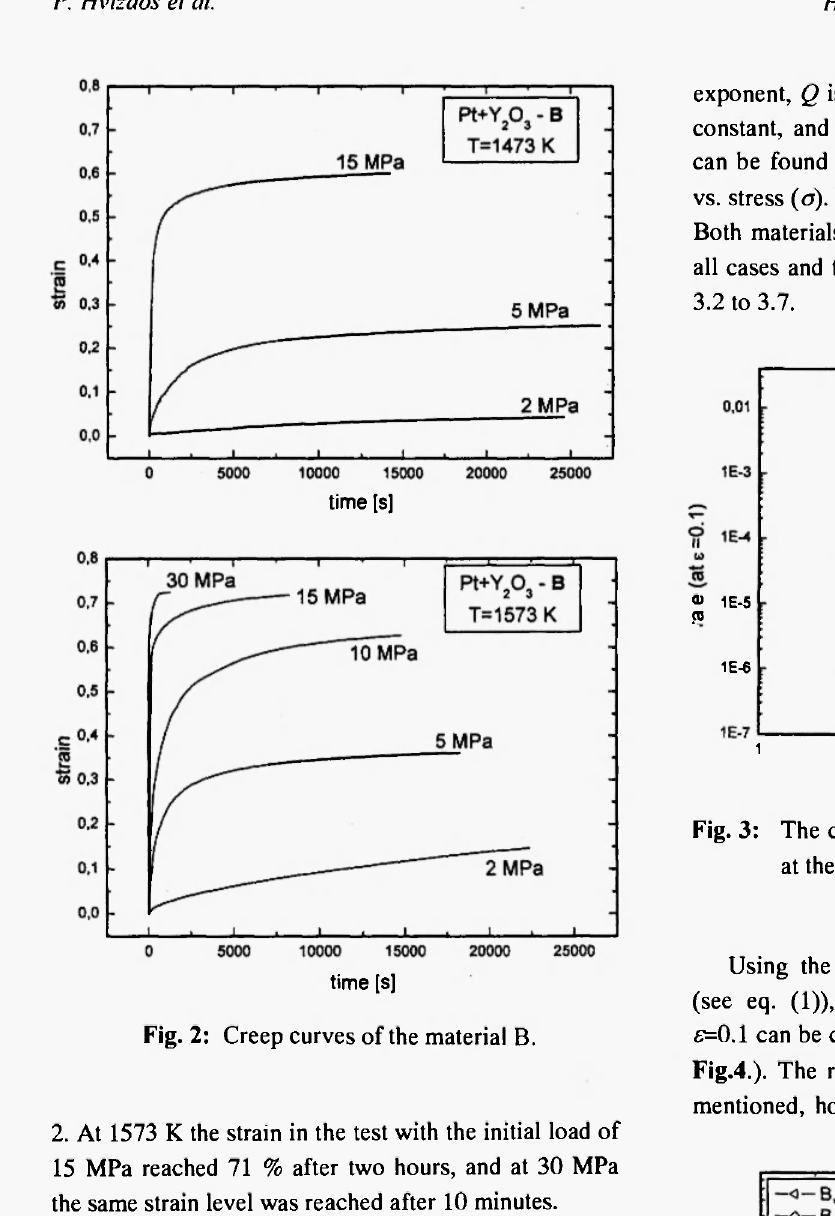
2. At 1573 Κ the strain in the test with the initial load of 15 MPa reached 71 % after two hours, and at 30 MPa the same strain level was reached after 10 minutes.